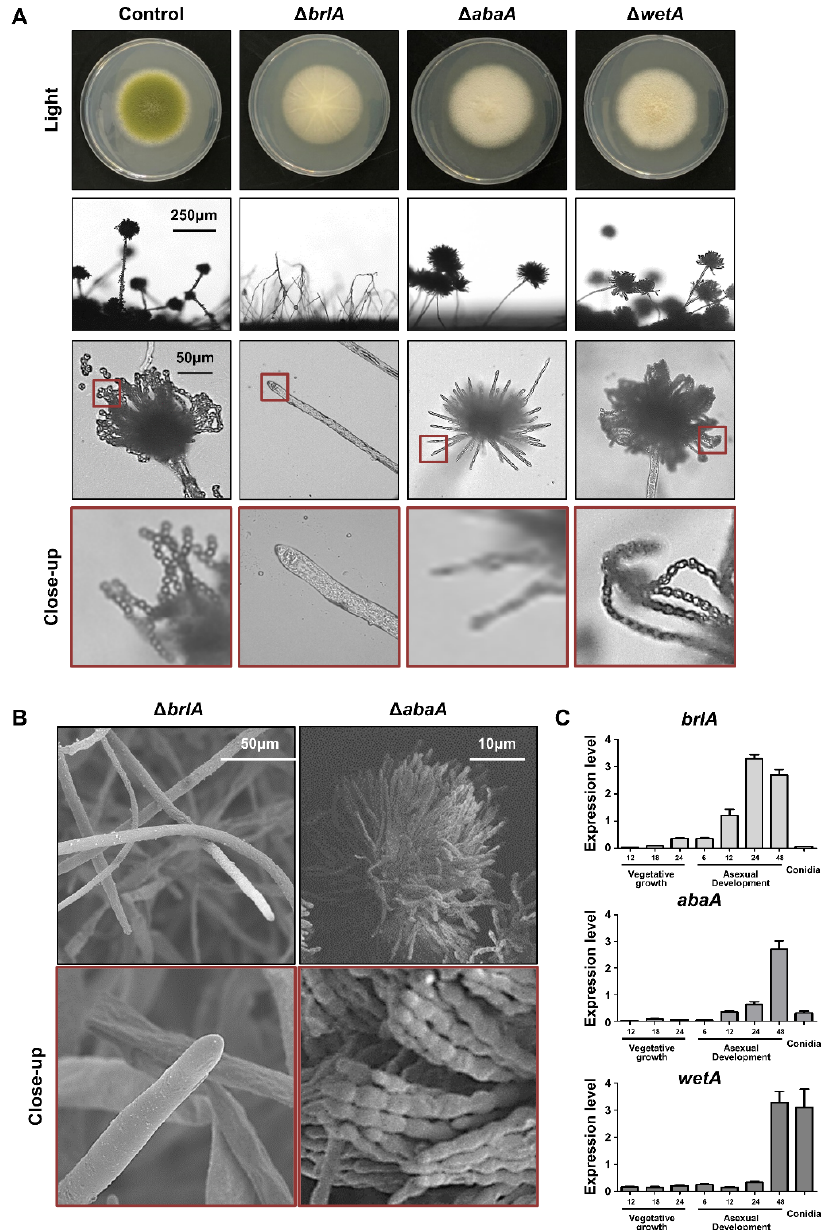
Figure 2. Summary of the central regulators in A. flavus . ( A ) Phenotypes of ∆ brlA , ∆ abaA , and ∆ wetA mutant strains. Colony phenotypes of ∆ brlA , ∆ abaA , and ∆ wetA strains point-inoculated on solid glucose minimal medium with 0.1% yeast extract media and grown at 37 ◦ C (Upper). Morphology of ∆ brlA , ∆ abaA , and ∆ wetA conidiophores observed under a light microscope at 48 h after inoculation onto solid MMYE media at 37 ◦ C (Bottom). ( B ) Scanning electron micrographs of ∆ brlA and ∆ abaA strains. ( C ) mRNA levels of brlA , abaA , and wetA during A. flavus life cycle. Samples for RT-qPCR analysis were collected from 12, 18, and 24 h of vegetative growth; 6, 12, 24, and 48 h of asexual development, and in conidia.